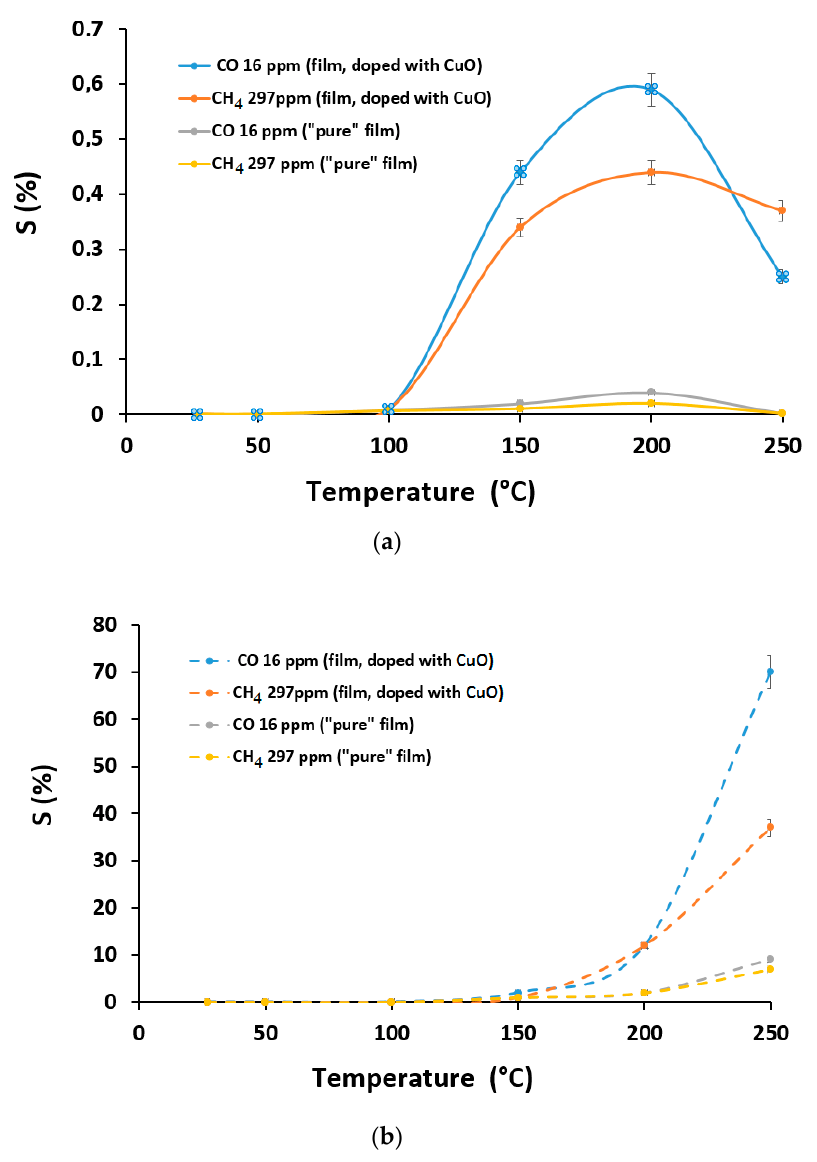
Figure 8. Relationship between the response and the optimal operating temperature of the sensors to 16 ppm CO and 297 ppm CH 4 for films: ( a ) type-1 and ( b ) type-2 chips.